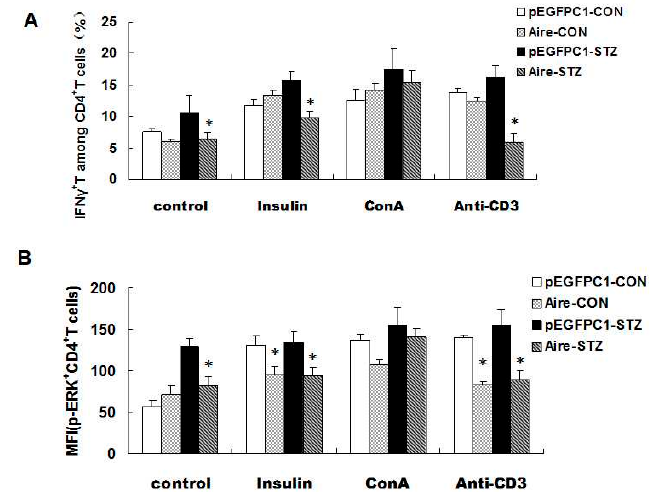
Figure 5. Adoptive transfer of Aire cells-co-cultured splenocytes suppressed autoreactive T cell activation by interfering with TCR signaling. Splenocytes from WT mice were co-cultured with Aire or control cells for 48 h. Then, the lymphocytes were isolated and injected into WT mice by tail vein followed by the induction of diabetes with STZ. The splenocytes were harvested and stimulated with insulin, ConA or CD3 antibody for 48 h prior to detection of the IFN- γ expression levels ( A ); and p-ERK expression levels ( B ) in CD4 + T cells by FACS. The results are presented as the mean values ± SD. Each experiment was repeated three to five times, and each group was compared with the pEGFPC1 group; * p < 0.05, Aire vs. pEGFPC1.